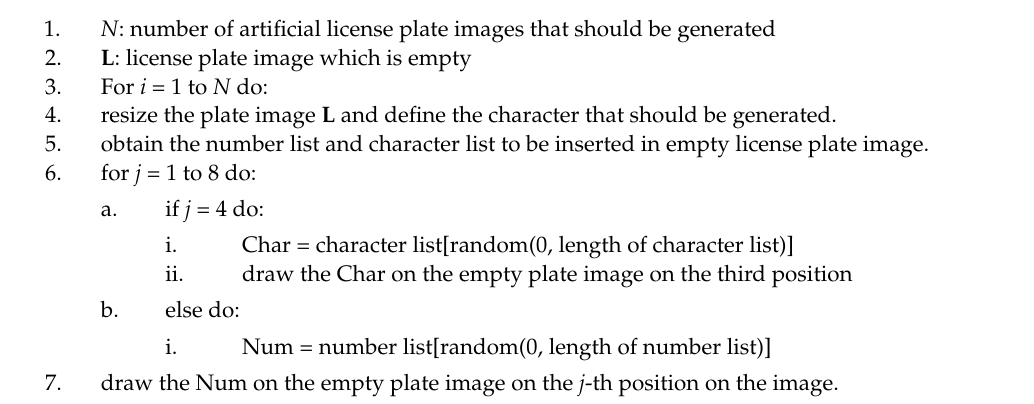
Algorithm 2. Artificial license plate image generation